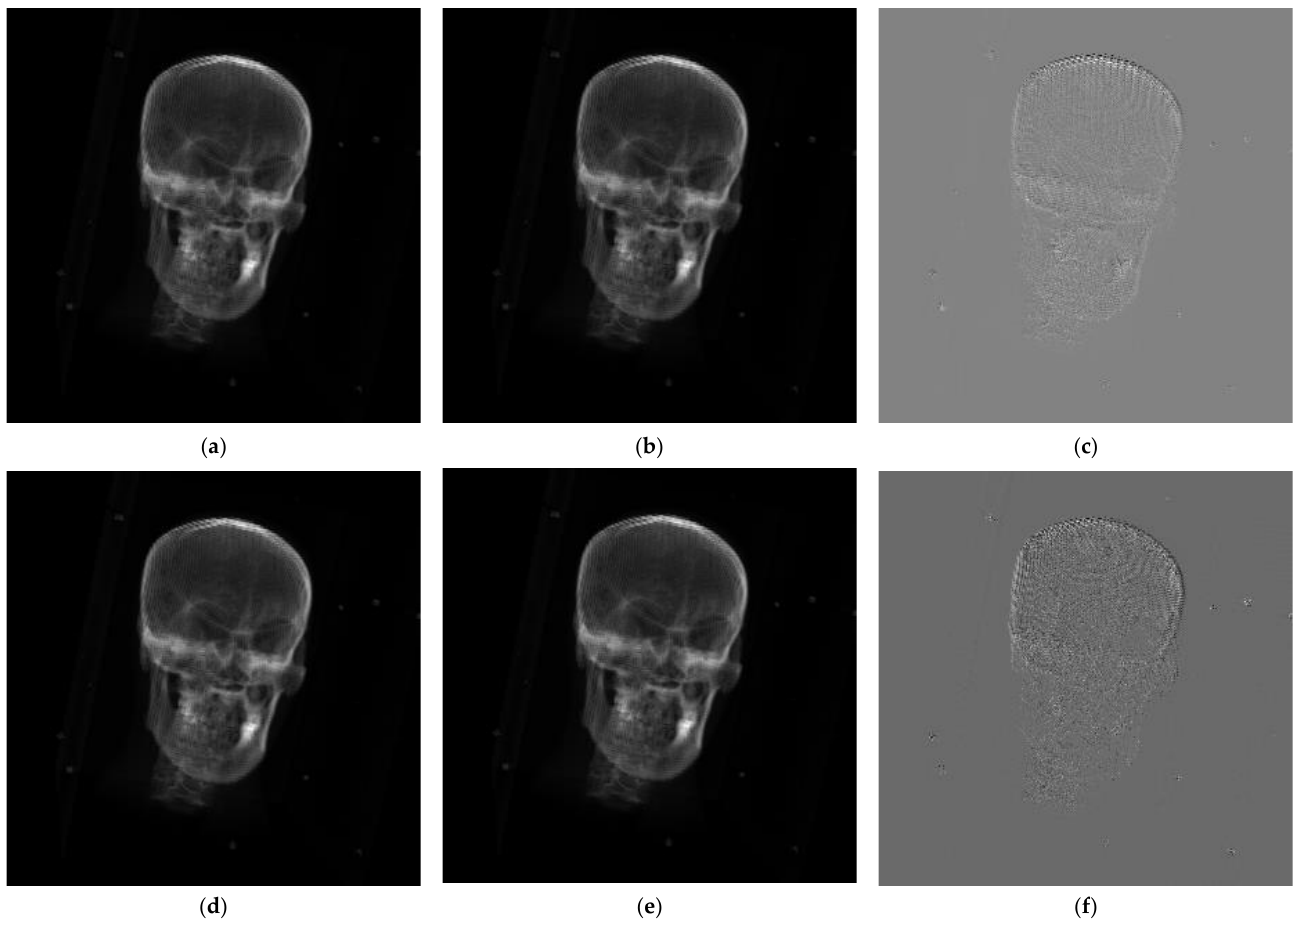
Figure 5. The results of Experiment 2: ( a ) reference image 2; ( b ) DRR image based on WSHGD registration; ( c ) difference image after registration based on the WSHGD; ( d ) reference image 2; ( e ) DRR image registered based on WHGD; ( f ) difference image after registration based on the WHGD.